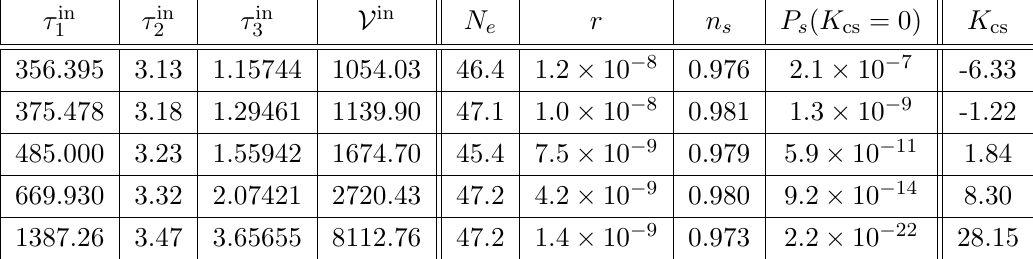
Table 3 . Initial conditions, number of efoldings and predictions for the cosmological observables for the (cid:12)ve parameter choices given in table 2. The values of K cs are those needed for obtaining the correct COBE normalisation of the scalar power spectrum P s ( K cs can be positive or negative depending on the stabilised value of the complex structure